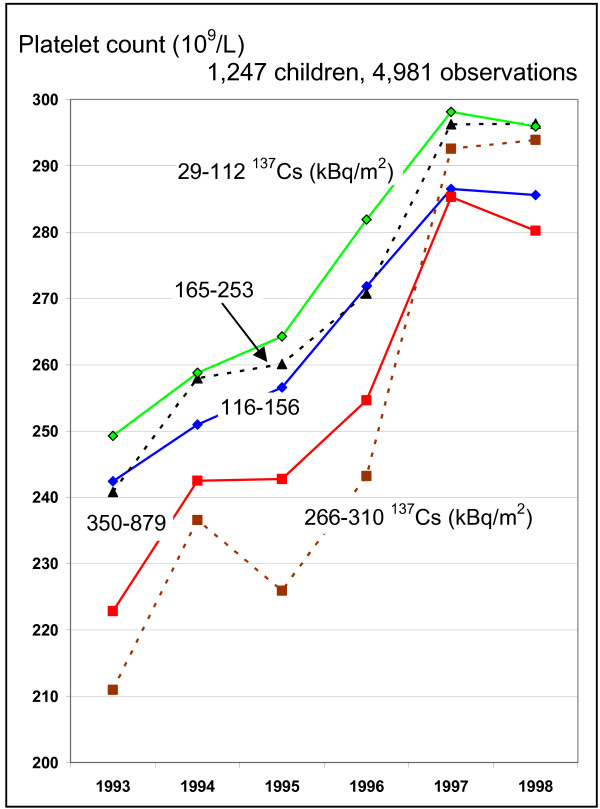
Changes of platelet counts over the years of observations by 137Cs exposure. The 137Cs contamination is grouped into quintiles.